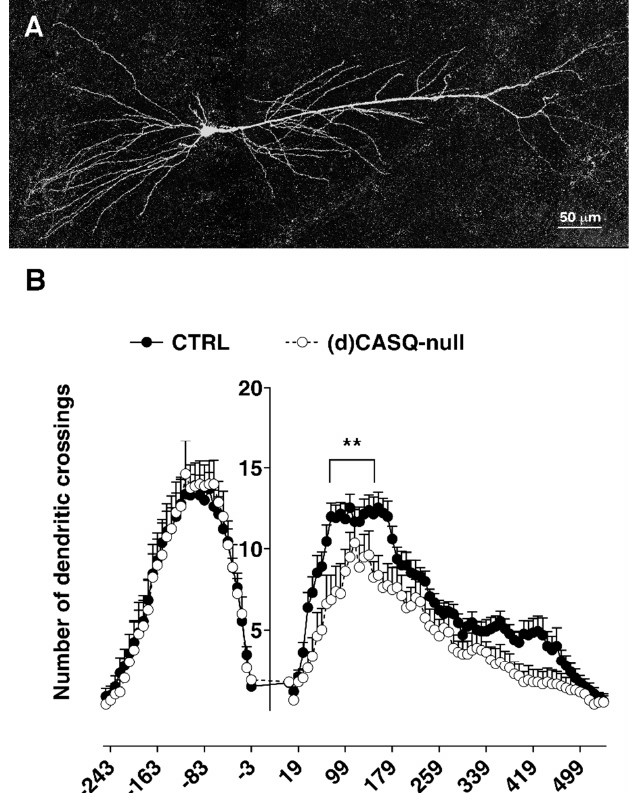
Figure 5. Dendritic tree complexity analysis of CA1 pyramidal neurons. ( A ) Picture showing an example of CA1 pyramidal neuron filled with biocytin and reconstructed by a confocal microscope used to perform the Sholl analysis. ( B ) The graph represents the number of dendritic crossings along the concentric Sholl rings at di ff erent distances from the soma. n = 13 cells from 6 animals vs. n = 8 cells from 6 animals in CTRL and (d)CASQ-null, respectively. Two-way ANOVA test: apical dendrites F(1, 19) = 7.196, p < 0.05; Sidak’s multiple comparisons test (75 µ m ** p < 0.01; 83 µ m ** p < 0.01; 91 µ m ** p < 0.01; 155 µ m * p < 0.05; 163 µ m ** p < 0.01; 171 µ m * p < 0.05); basal dendrites F(1, 608) = 0.005,